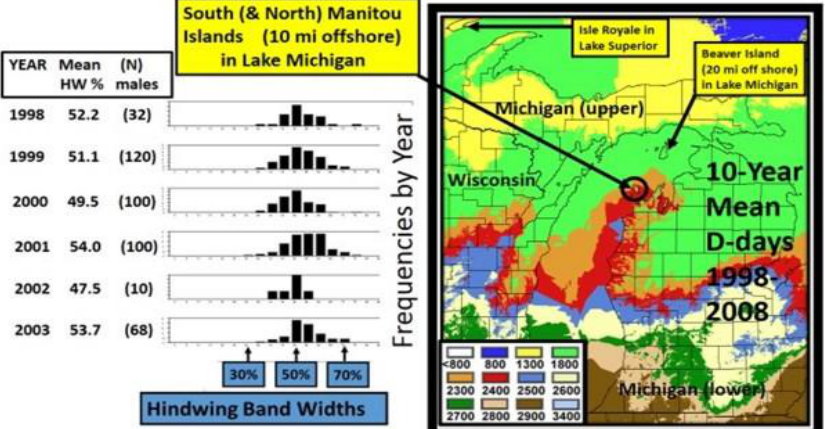
Figure 15. South Manitou Island in Lake Michigan appears to serve as a refuge for recombinant hybrid genotypes of Papilio despite being at high latitudes (45° N). Hindwing (cid:69)(cid:68)(cid:81)(cid:71)(cid:90)(cid:76)(cid:71)(cid:87)(cid:75)(cid:86)(cid:3)(cid:82)(cid:73)(cid:3)(cid:80)(cid:68)(cid:79)(cid:72)(cid:86)(cid:3)(cid:68)(cid:85)(cid:72)(cid:3)(cid:70)(cid:79)(cid:72)(cid:68)(cid:85)(cid:79)(cid:92)(cid:3)(cid:179)(cid:75)(cid:92)(cid:69)(cid:85)(cid:76)(cid:71) - (cid:79)(cid:76)(cid:78)(cid:72)(cid:180)(cid:3)(cid:11)(cid:69)(cid:72)(cid:87)(cid:90)(cid:72)(cid:72)(cid:81)(cid:3)(cid:23)(cid:19) % and 55%; see also Figures 13 and 14), though they have increased slightly in 2006 (cid:177) 2008 (57.7%, n = 131; 55.6%, n = 95; and 58.1%, n = 82, respectively). The 10-year average Degree-day accumulations across Wisconsin and Michigan reflect climate warming during 1998 to 2008, and the warmer western coast if Michigan. This island population also supported other hybrid-like traits, including glaucus -like tulip tree detoxification abilities, Z-linked allozymes (Pgd-100), and the enabler gene (b+) for female melanism [24,150,281,363] (see also Figure 16a,b). Such evidence of introgression was not found in other island populations on Beaver Island to the North, or the Isle Royale in Lake Superior